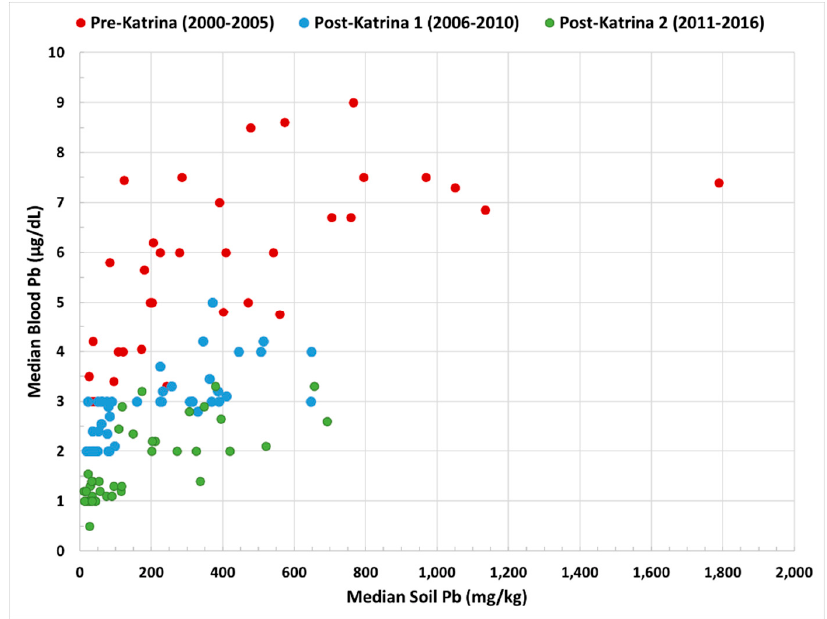
Figure 3. The Y axis shows the median children’s blood Pb in 44 communities for 1998–2000 (red) compared with communities surveyed in 2006–2010 (blue) and 2011–2017 (green). For each community children’s median blood Pb are paired in the X axis with the corresponding median soil Pb.